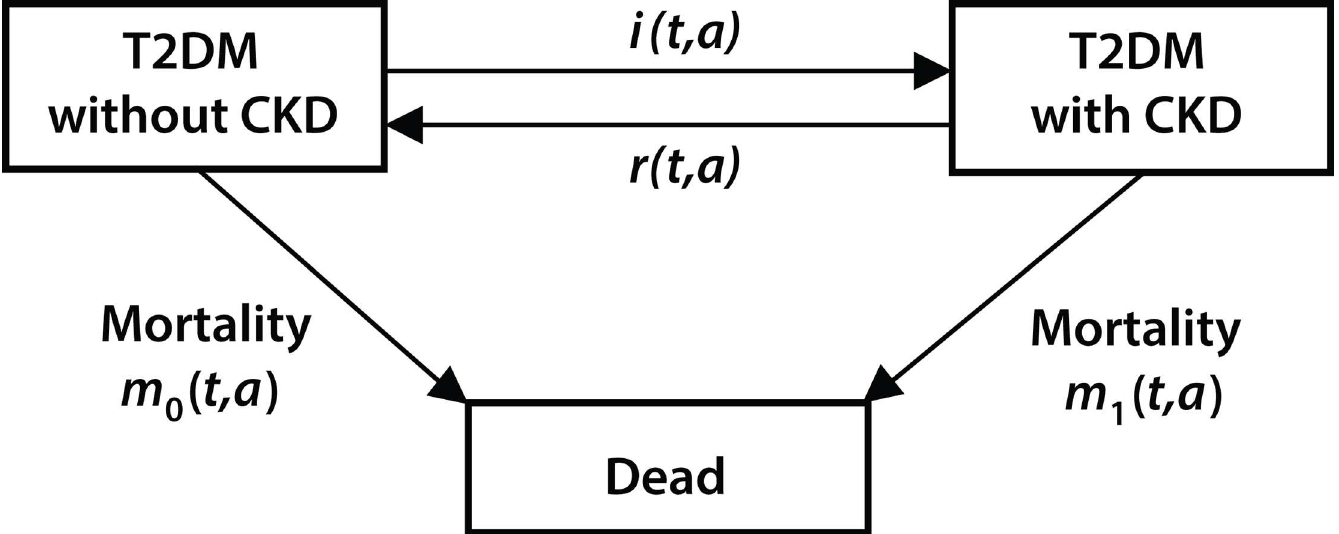
Fig 1. Illness-death model with transition rates ( i , r , m 0 , m 1 ). CKD, chronickidney disease;T2DM, type 2 diabetes mellitus.